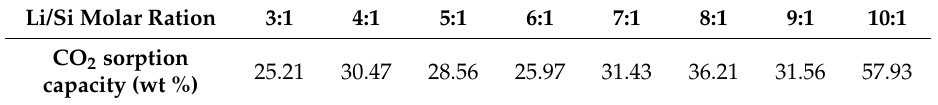
Table 2. CO 2 sorption capacity of Li 4 SiO 4 -(EX-VMT)- x ( x = 3, 4, 5, 6, 7, 8, 9, and 10) samples at 650 ◦